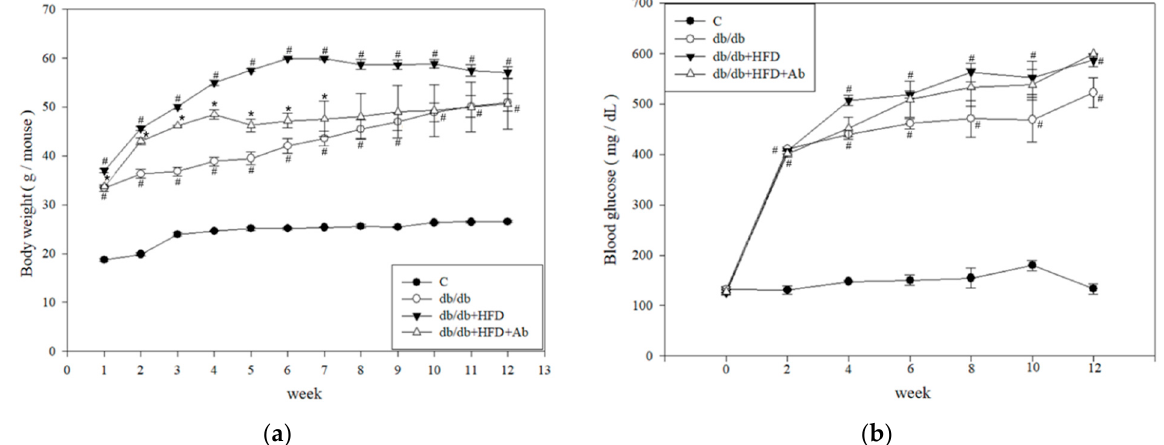
Figure 1. Ab decreased body weight and blood glucose in db/db mice with an HFD. During the experiment, db/db mice were fed an HFD and Ab. ( a ) The body weight of mice was measured once a week. ( b ) Fasting blood glucose from mice was tested every two weeks. Data are presented as mean ± SD; n = 3 mice per group. The results were analyzed using the analysis of variance. #, p < 0.05 compared with the control group. *, p < 0.05 compared with the db/db+HFD group.